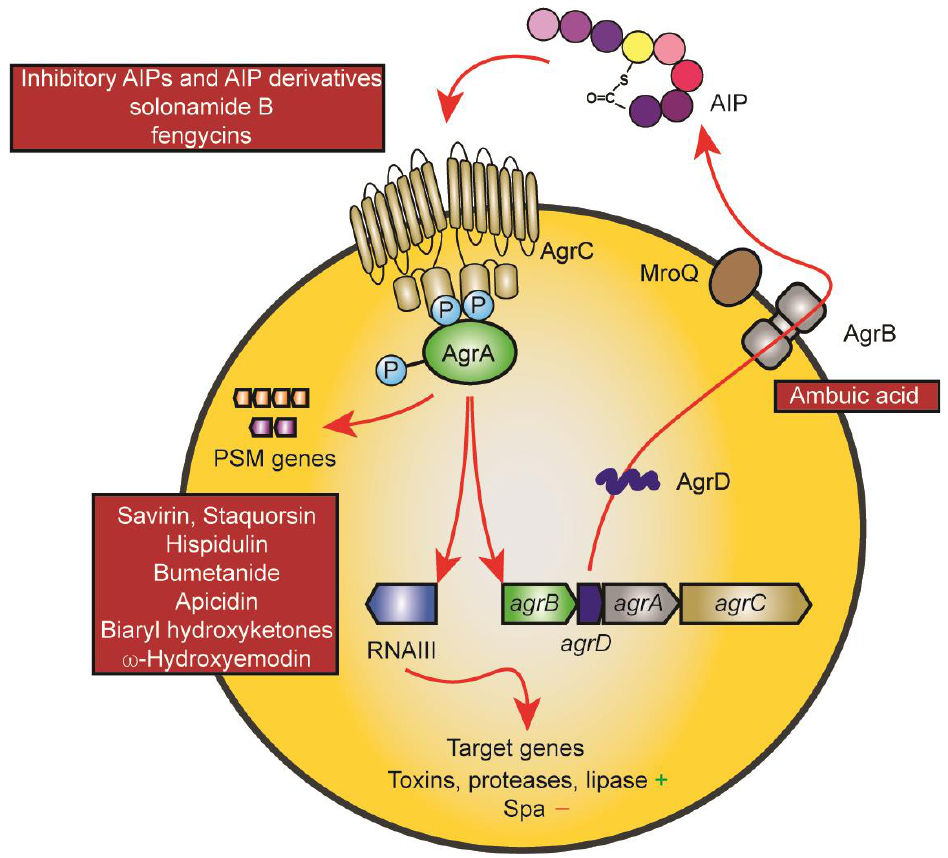
Figure 1. The Agr system and points of drug interference. The mechanisms underlying the Agr quorum-sensing circuit and target gene control are shown using red arrows. The AgrD AIP precursor is modified and exported by AgrB and further proteolytically trimmed by MroQ. Upon reaching a threshold concentration, the AIP leads to auto-phosphorylation of the membrane AIP sensor histidine kinase AgrC, which then leads to phosphorylation of the response regulator protein AgrA. AgrA promotes transcription from the promoters of the Agr system ( agrBDCA promoter) and of the promoter controlling transcription of RNAIII, a regulatory small RNA that controls Agr target gene expression. PSM genes are under exceptional, direct control by AgrA promoter binding. Main points of attack by drugs are the AIP-AgrC interaction (top left) and AgrA and its interaction with target promoters (bottom left). The only drug targeting another mechanism is ambuic acid, which has been reported to interfere with AIP biosynthesis (AgrB).